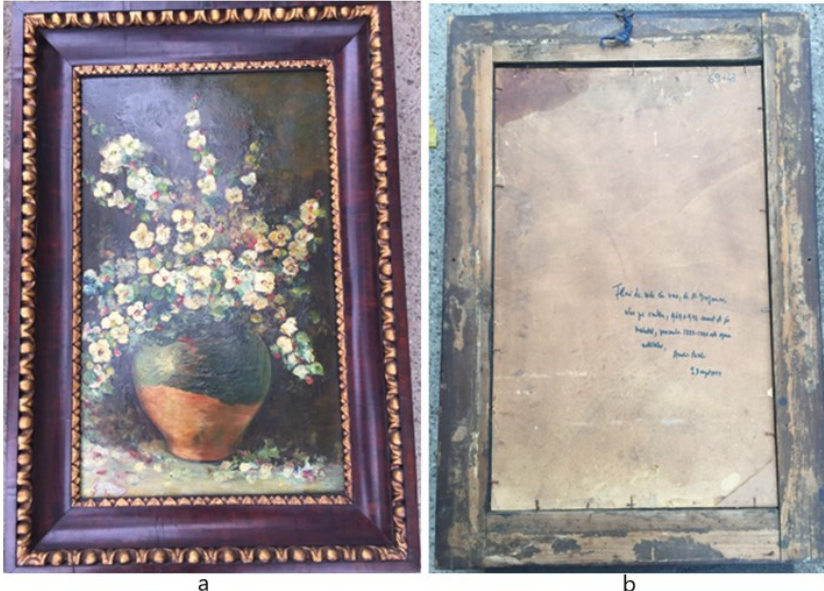
Figure 1. The painting “Flowers of apple”, attributed to the painter Nicolae Grigorescu. (period 1888–1890): ( a ) front; ( b ) back.